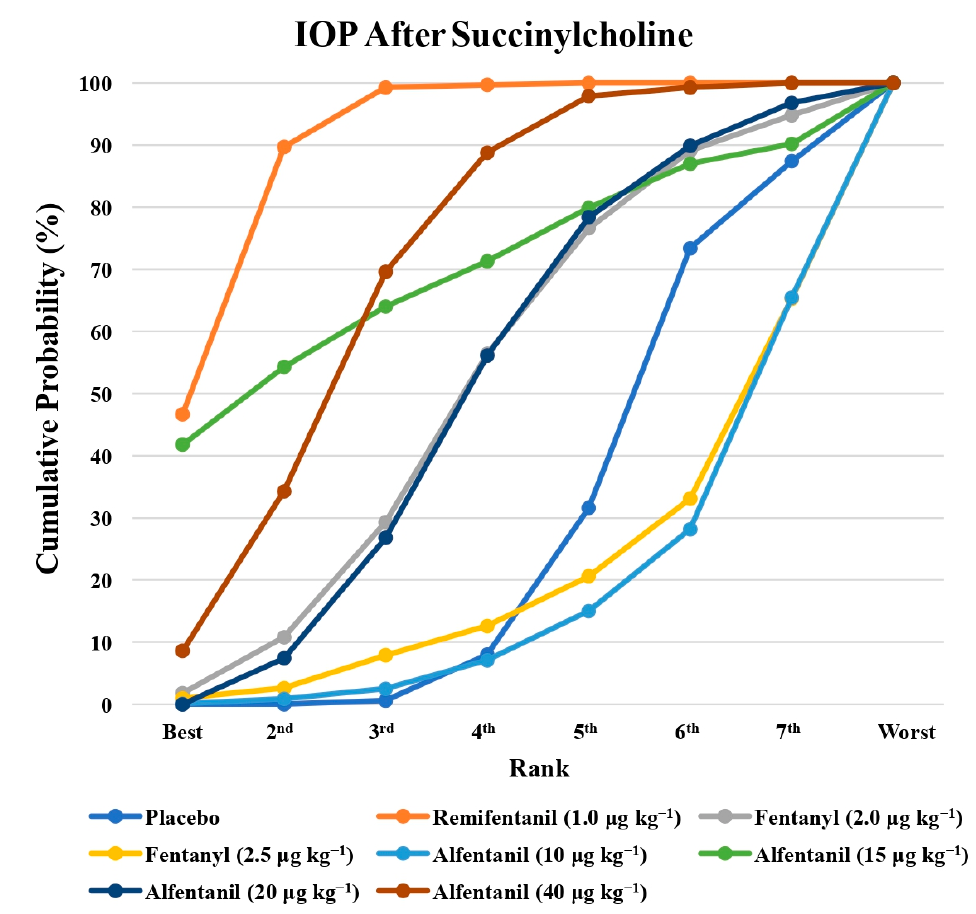
Figure 9. The cumulative ranking probability of the effects of each treatment on the intraocular pressure after succinylcholine.